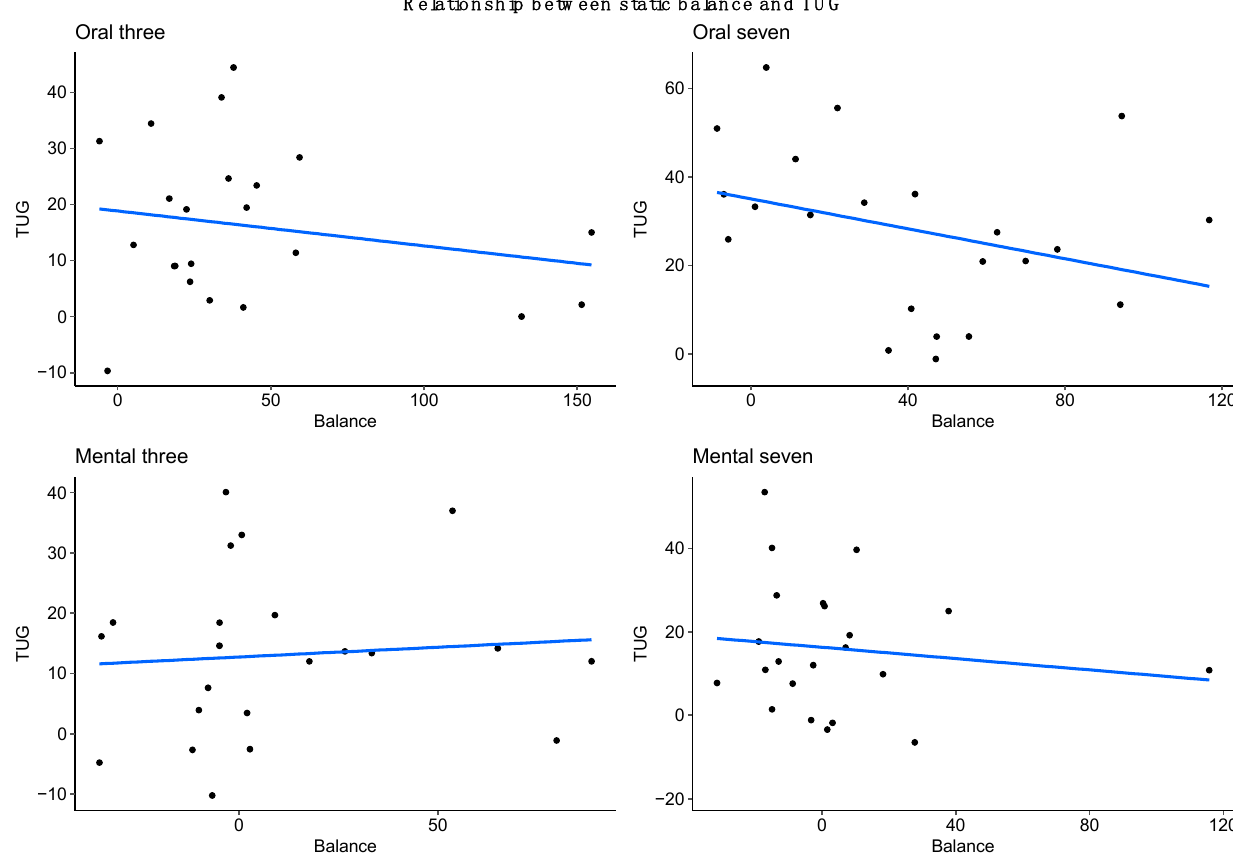
Figure 3. Relative changes (percentage of change relative to the control condition) for the different tasks for TUG and balance.